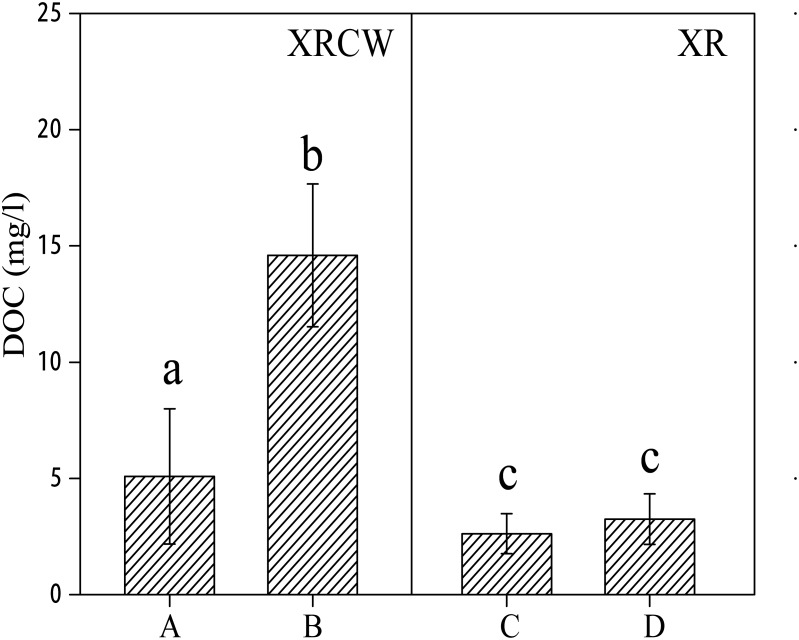
The spatial distribution of dissolved organic carbon (DOC).Bar plots showing the spatial distribution of dissolved organic carbon (DOC) in the Xinxue River (XR) and Xinxue River Constructed Wetland (XRCW). A = upstream location of XRCW; B = downstream location of XRCW; C = upstream location of XR; D = downstream location of XR. Bars sharing the same lowercase letter (a or b) are not significant at α = 0.05 (Duncan Test).